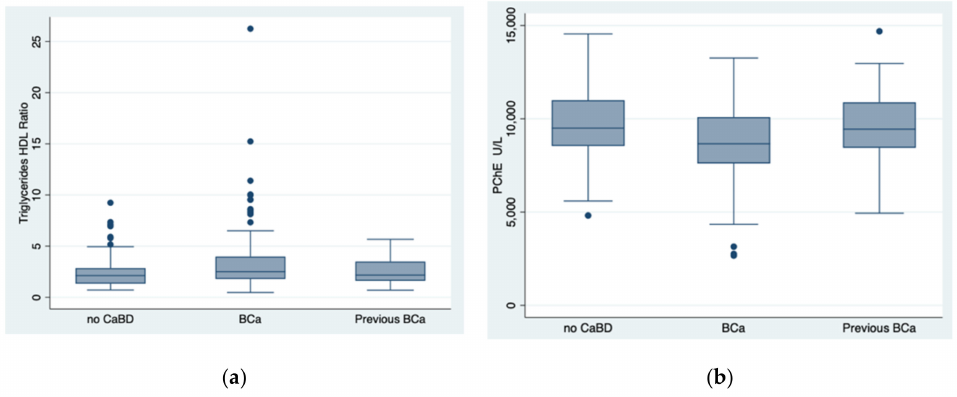
Figure 1. The behaviour of the TG/HDL ratio and pseudocholinesterase levels in the three groups, i.e., no cancer but bladder disease, bladder cancer, and previous bladder cancer. BCa, bladder cancer; no CaBD, no cancer but bladder disease; previous BCa, previous bladder cancer; PChE, pseudocholinesterase. Indeed, there was a statistically significant difference (Kruskal–Wallis test) for the TG/HDL ratio between the groups ( p = 0.023): specifically, between no CaBD and BCa groups ( p = 0.005), as well as between previous BCa and BCa groups ( p = 0.04). ( a ) Similarly, there was a statistically significant difference found by the same test for PChE between the groups ( p = 0.0005): specifically, between no CaBD and BCa groups ( p = 0.0004), as well as between previous BCa and BCa groups ( p = 0.0019) ( b